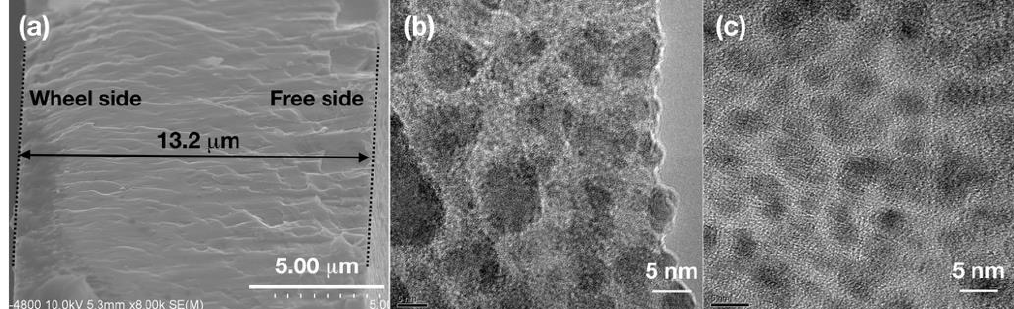
Figure 3. HR-TEM (high-resolution transmission electron microscopy) micrographs of thick films ( b ), SAT-10; ( c ), SATS-10 developed by melt spinning. A cross section SEM image of film SAT-10 ( a ), was placed to help readers to have an overall understanding of the thick films. Both TEM specimen were thinned from melt-spun films using ion bombardment without any other processing or treatment.